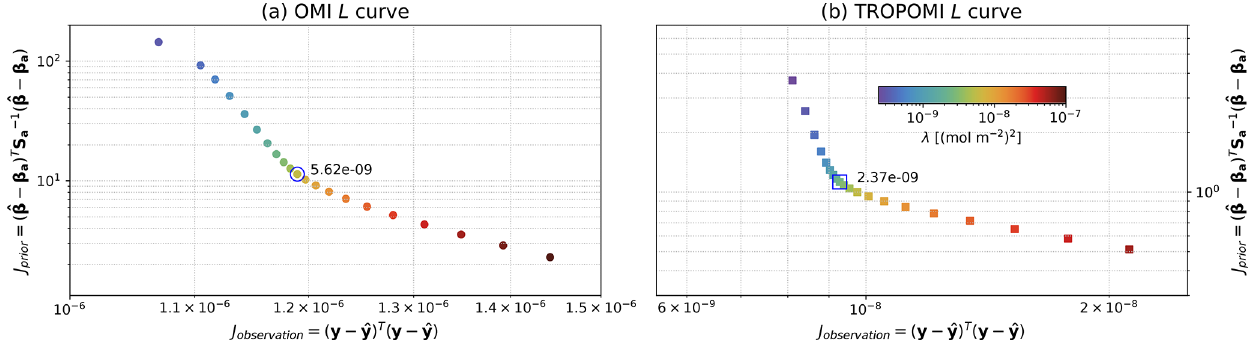
Figure B2. Similar to Fig. B1 but showing L-curve plots for the optimal estimation for all calendar months for OMI (a) and TROPOMI (b) .